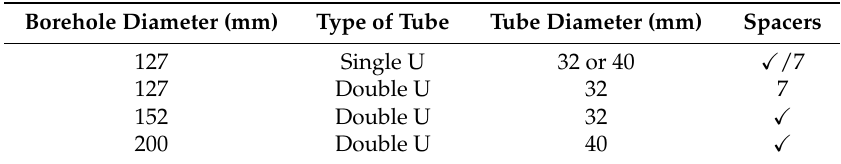
Table 1. Usual configurations used in vertical closed-loop systems, (cid:88) = Pipes with spacers, 7 = Pipes without